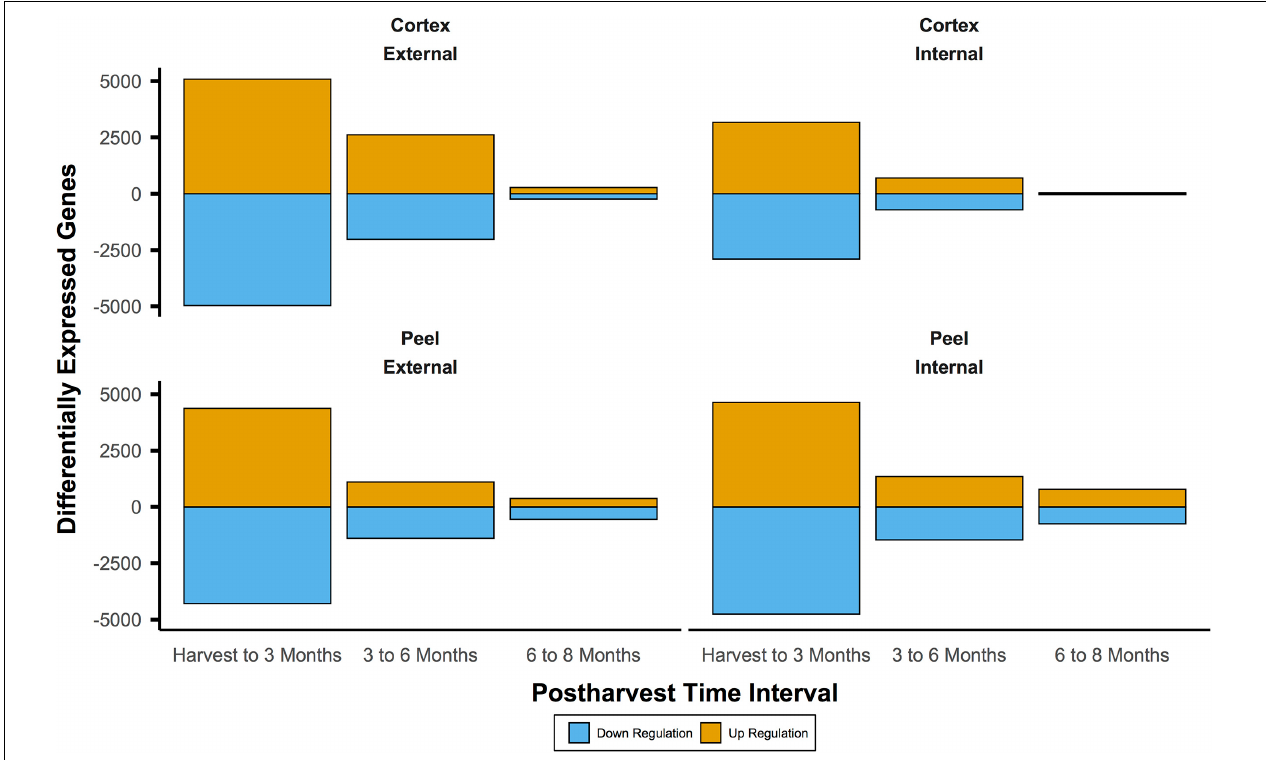
FIGURE 2 | The number of differentially expressed genes was initially large and diminished through time. This pattern indicates large shifts of expression during the first three months of controlled atmosphere storage at − 0.5 ◦ C may be involved in ripening processes. This includes gain of the chilling-induced capacity to ripen for European pear varieties like ‘d’Anjou’. It also shows that massive shifts in gene expression may obscure useful biosignatures. Significant differential expression was determined by Bonferroni corrected P < 0.05.